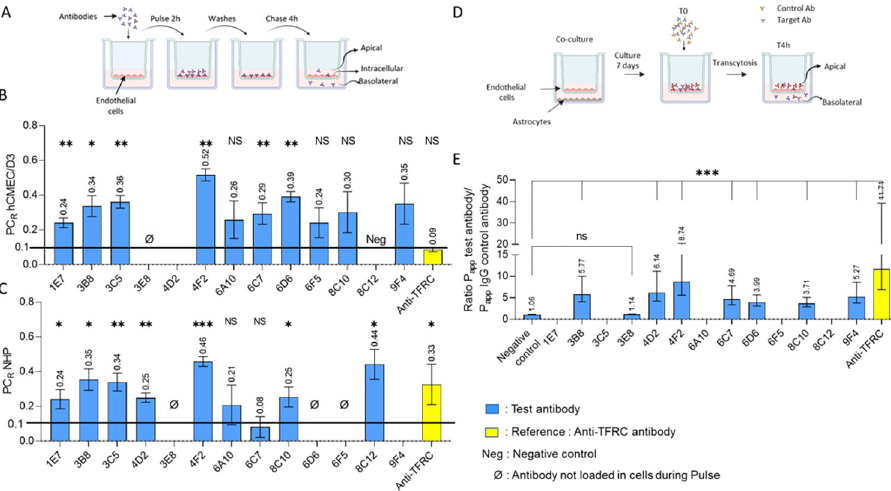
which transcytosis had already been demonstrated [33]. All following data for evaluation in the three transcytosis models were reported in S1 and S2 Tables. hCMEC/D3 pulse-chase experiments. “Pulse-chase” experiments were conducted as described by Sade et al. [52] to evaluate transcytosis capabilities in cells without strong tight junctions (Fig 2A). We used the same protocol for hCMEC/D3 cells and for NHP BMECs for which we had determined a TEER value below 150 Ω .cm 2 .